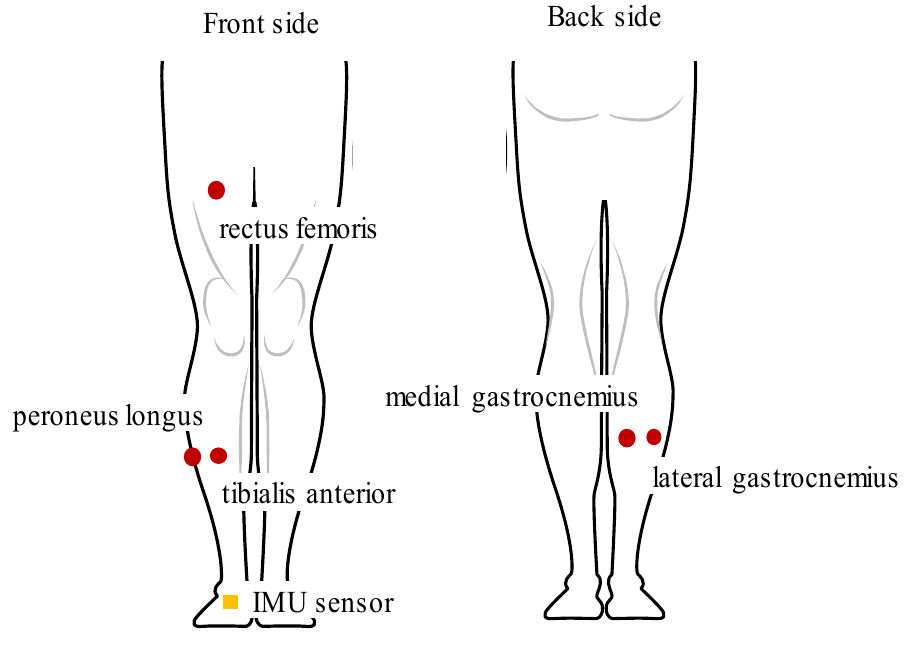
Figure 2. Illustration of EMG and IMU sensor location.